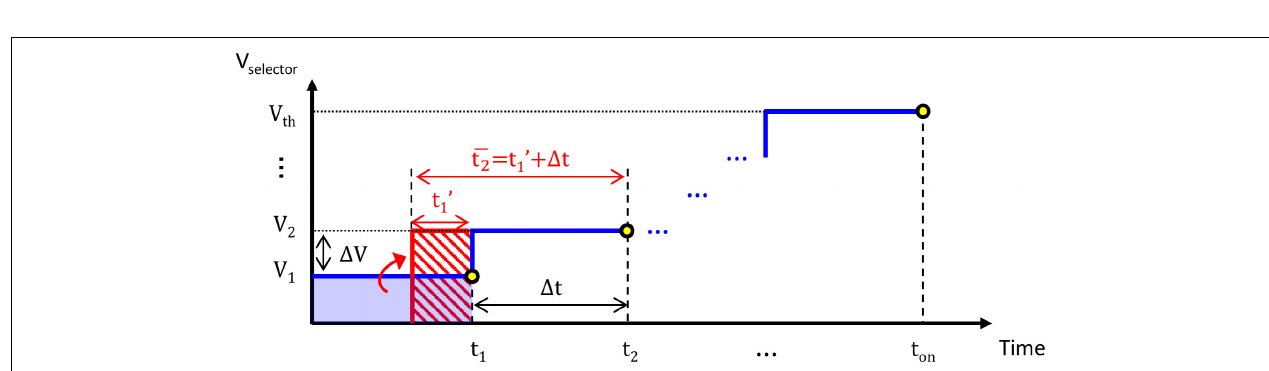
FIGURE 5 | Time-varying V selector in the neuron circuit is approximated using a finite number of constant voltage stress (CVS) steps from ( t 1 , V 1 ) to ( t 2 , V 2 ) and eventually to ( t on , V th ). (cid:49) V and (cid:49) t determine the voltage and time intervals, respectively. Based on the proposed V–t Model, the transformed ( t 1 , V 2 ) step indicated by the red-dashed rectangle is equivalent to the ( t 1 , V 1 ) step indicated by the blue-filled rectangle. The new t 2 of V 2 is now t (cid:48) 1 + (cid:49) t , which includes the history effect of the previously accumulated ( t 1 , V 1 ) step.